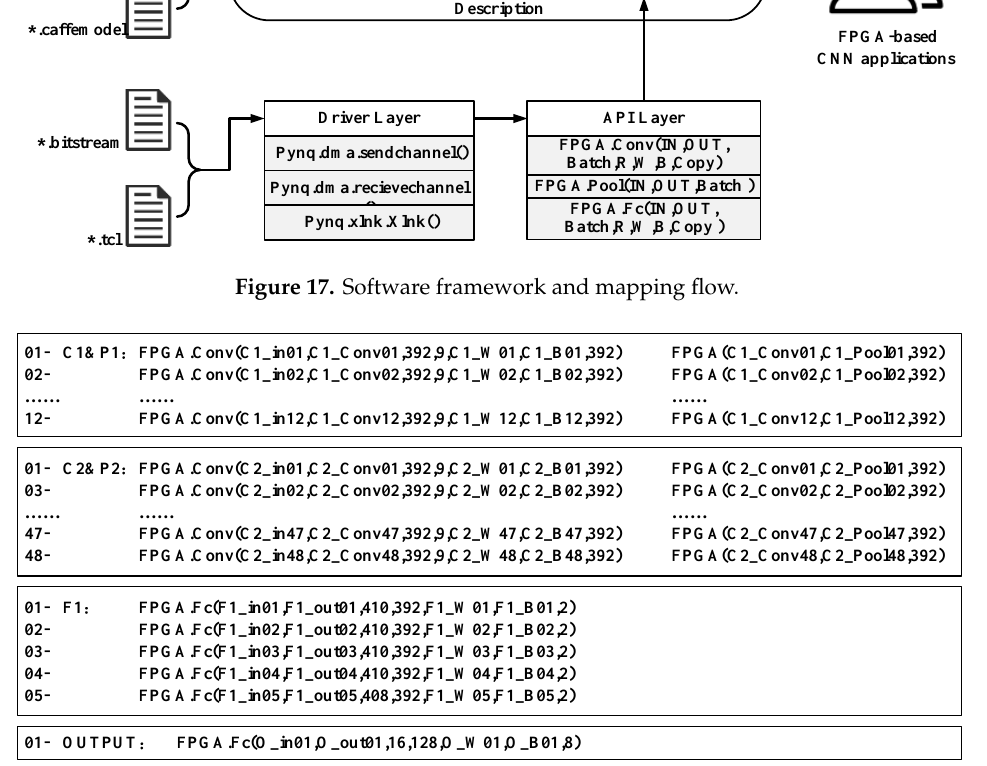
Figure 18. LeNet-F model-3 constructed by using an API